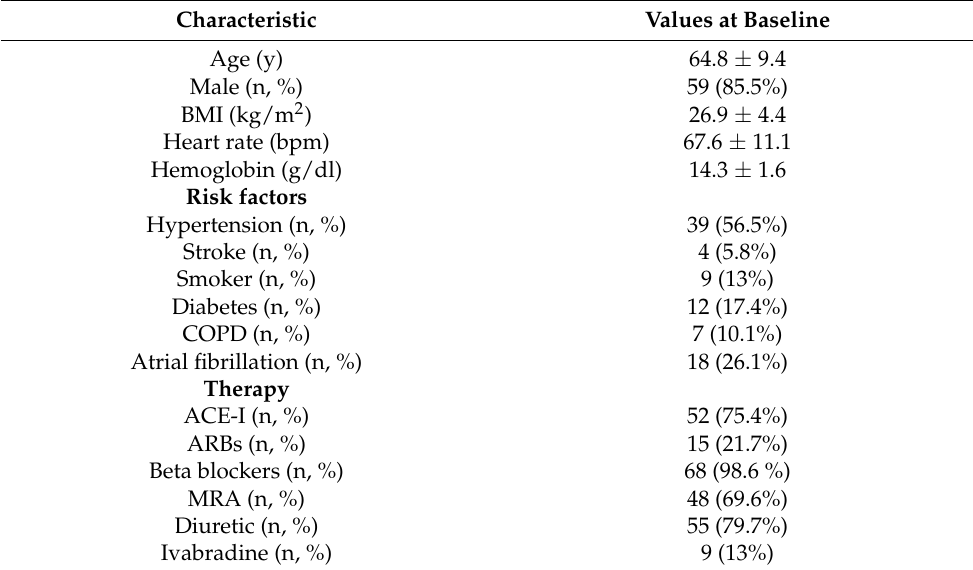
Table 1. Characteristics of the study population at